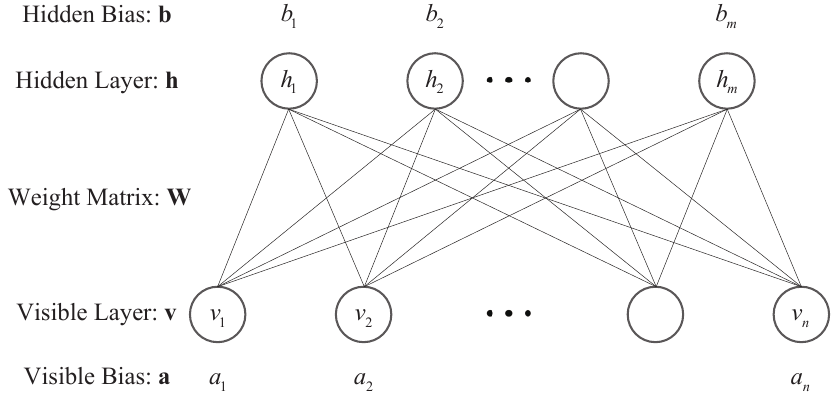
Figure 1. The structure of a typical RBM